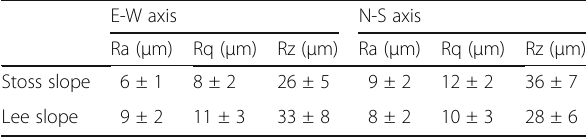
Table 1 Roughness parameters for both N-S and E-W axes obtained from surface scans of stoss and lee